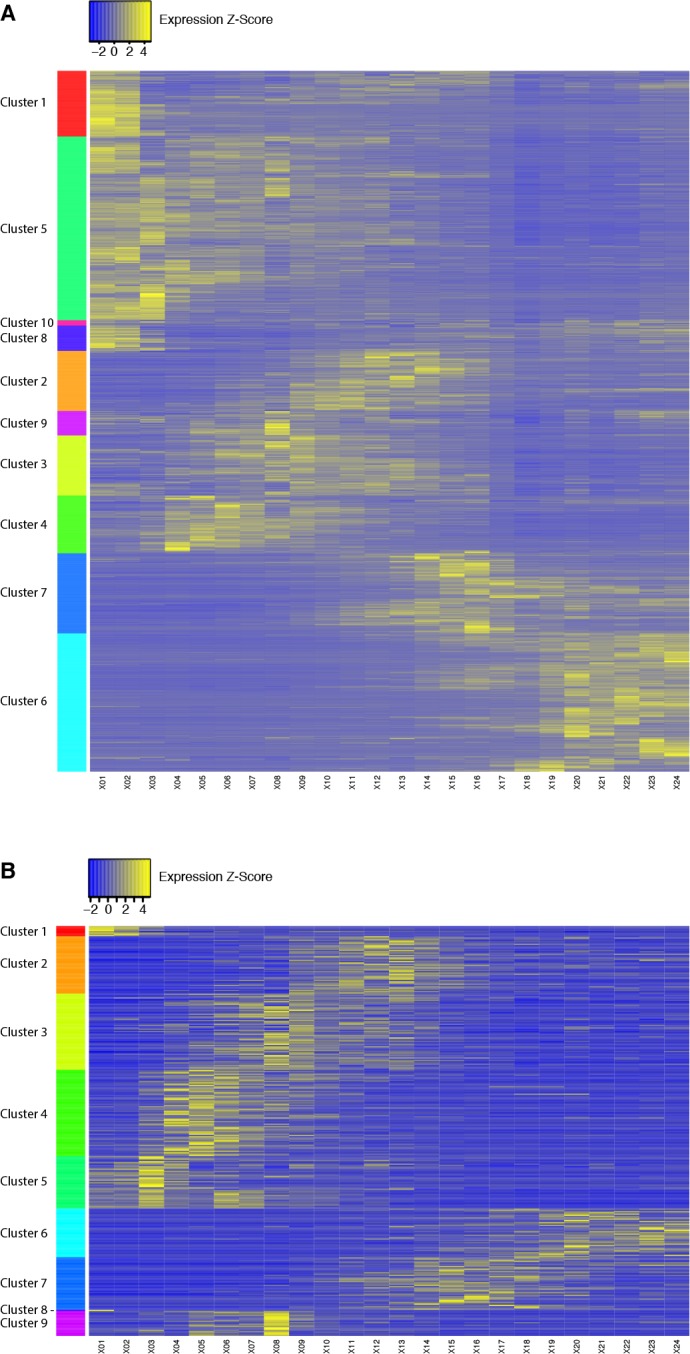
Clustering of D. melanogaster developmental expression profiles.In order to analyze co-expression between putative lncRNA and protein-coding gene promoters, we first grouped protein-coding gene promoter expression profiles by k-means clustering (10 clusters) to define reference co-expression sets (A). We then clustered both lncRNA and protein-coding gene promoter profiles together, and extracted the lncRNA promoter profiles corresponding to each expression cluster previously defined (see B).